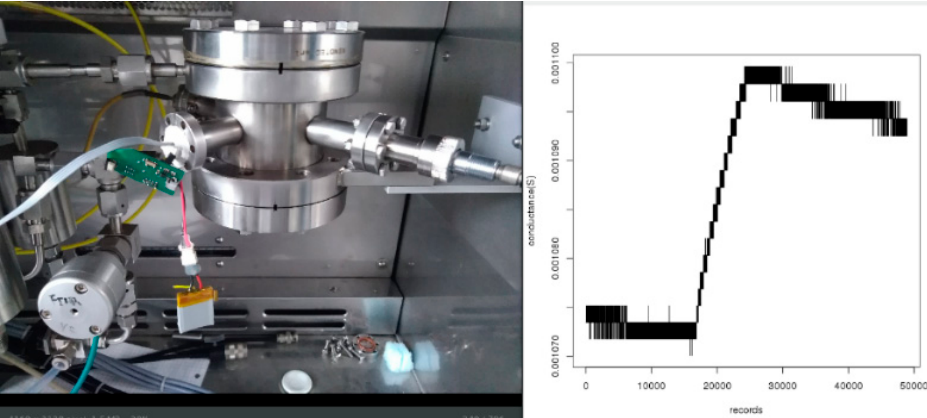
Figure 19. Pristine graphene-based sensor, named ENEA3, installed on LETI board, exposed to 300 ppb of NO 2 for 10